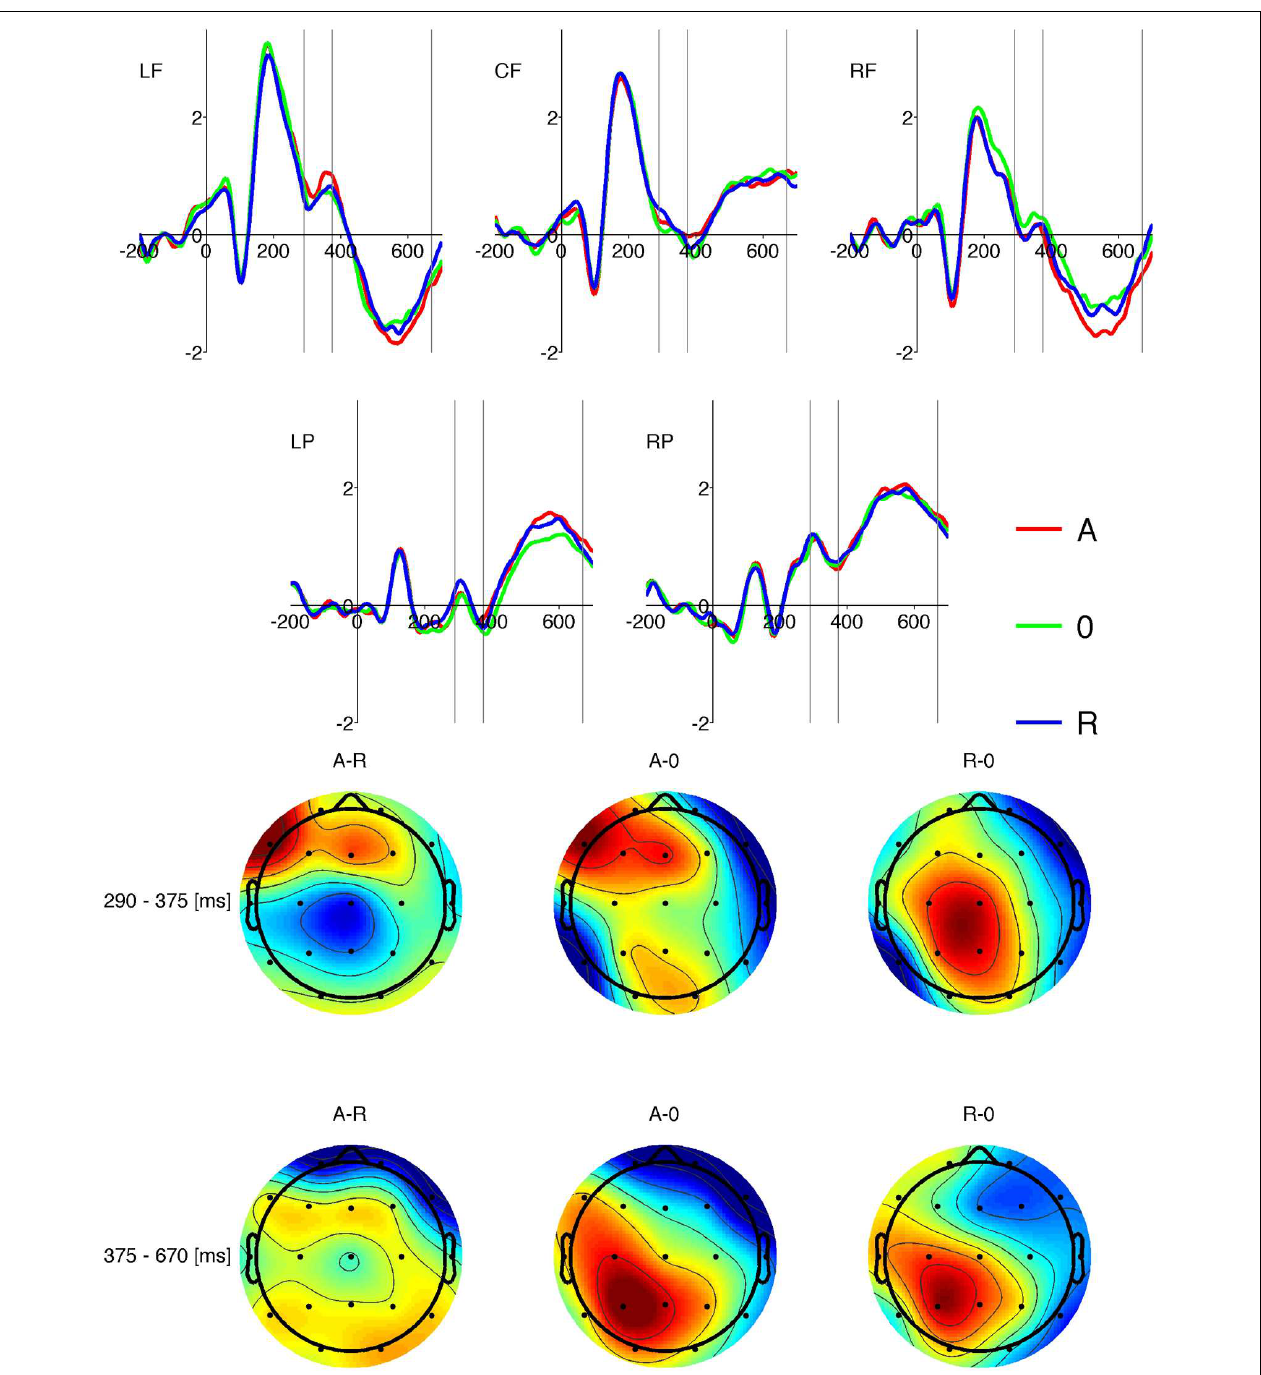
FIGURE 4 | Upper plots show grand average amplitudes of ERPs for different levels of origin (red: automatic; green: non-specific; blue: reflective) at the five ROIs (LF: left frontal; CF: centro-frontal; RF: right frontal; LP: left posterior; RP: right posterior). Vertical lines indicate the two time windows of interest. Lower plots Show the topographical distribution of differences in amplitudes between the origin levels displayed above each plot. The color scale is red for positive and blue for negative value of the difference.Upper row show data for the 290-375 ms time window, lower row shows data for the 375-670 ms time window.